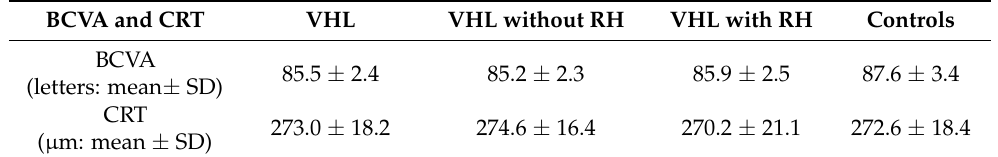
Table 8. BCVA and CRT in the analyzed groups.